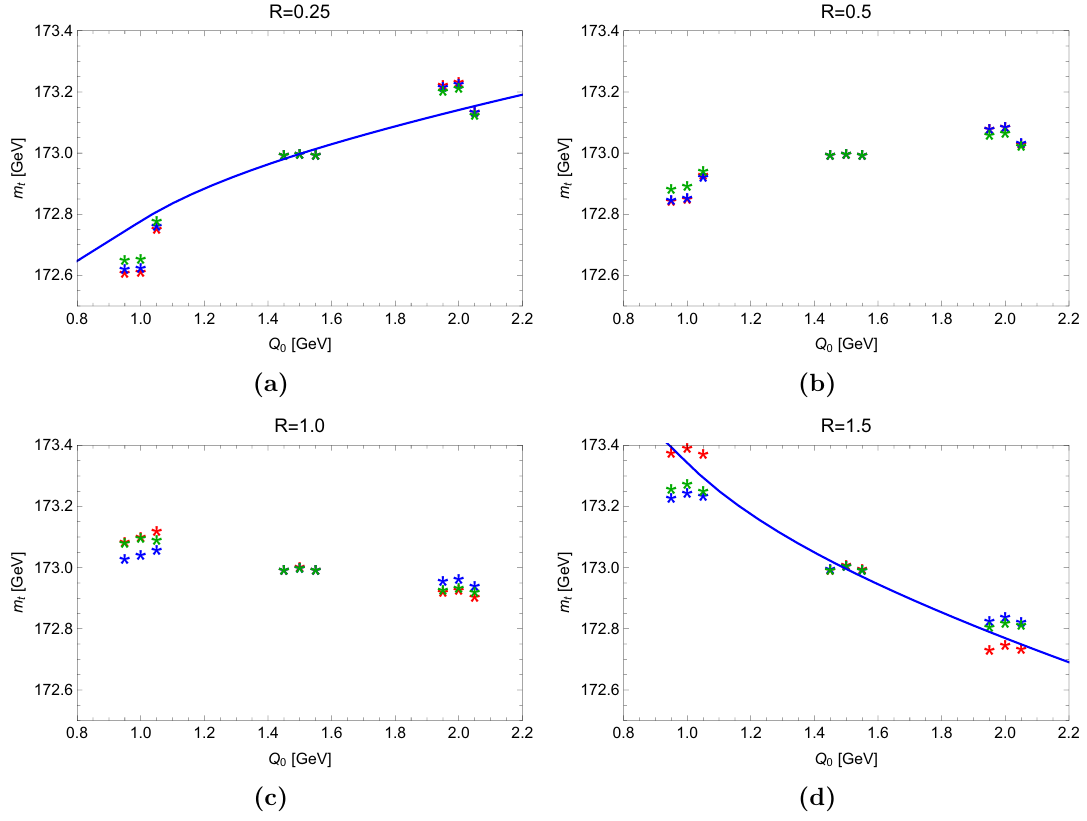
Figure 20. Fitted top quark mass obtained from the m b endpoint region for shower cut values j ‘ Q 0 = Q 0 ;b = 1 : 0, 1 : 5 and 2 : 0 GeV for Q = 700 GeV using the k t -type algorithm (green), the Cambridge-Aachen algorithm (blue) and the anti- k t -type algorithm (red) for b -jet clustering. For each Q 0 value the respective left set of symbols come from the LO simulations, the respective middle set of symbols come from simulations with MC@NLO-type matching and the respective right set of symbols from simulations with POWHEG-type matching. Displayed are the results for b -jet radii R = 0 : 25, 0 : 5, 1 : 0 and 1 : 5. The solid blue line in the lower right panel corresponds to eq. (7.5) and the one in the upper left panel corresponds to eq. (7.6) using Q 0 = 1 : 5 as the reference scale.